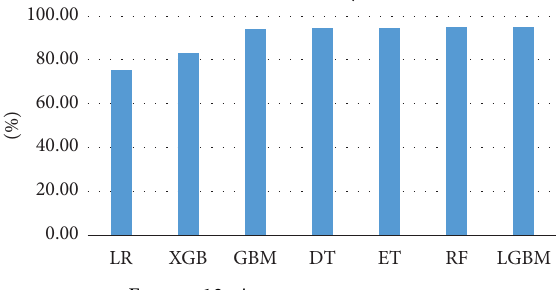
Figure 12: Accuracy percentage.